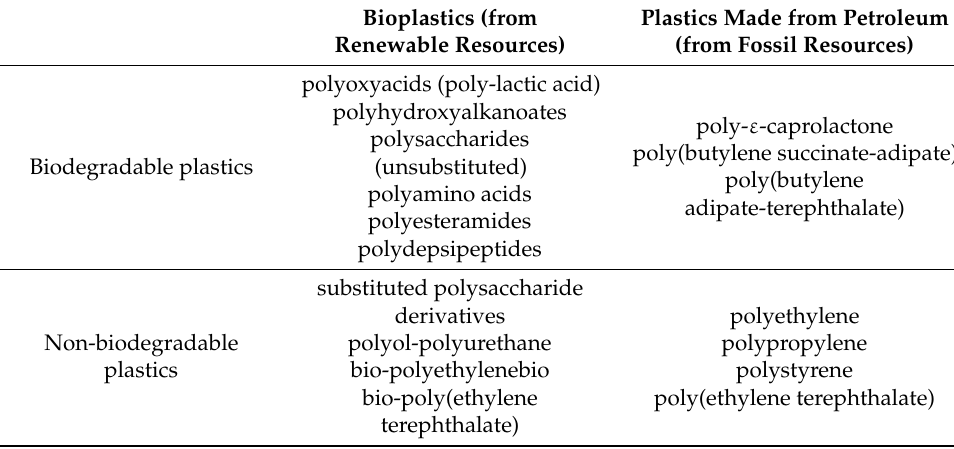
Table 1. Classification of plastics according to [46].